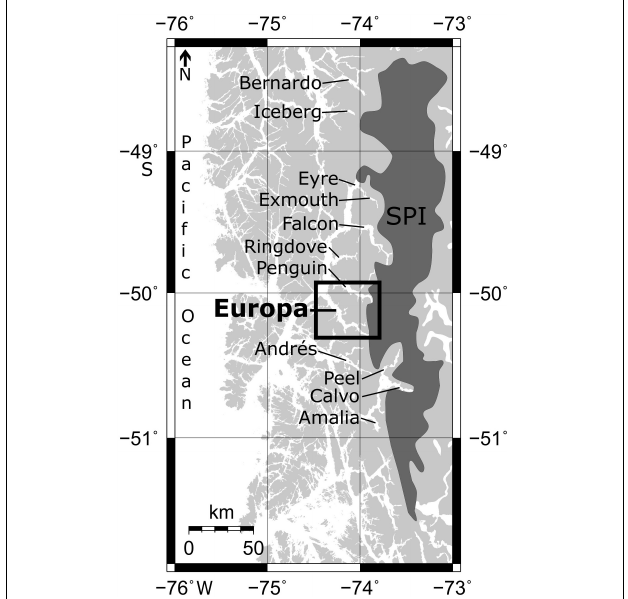
FIGURE 1 | Study area and Europa Fjord location. Approximate Southern Patagonian Icefield (SPI) coverage in the present time. Main fjords of the region are also